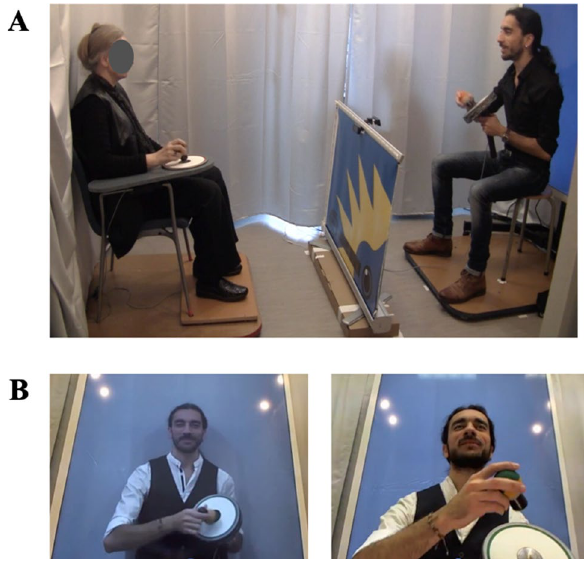
Figure 1. Experimental set-up. ( A ) The participant was seated in front of a musician, who sang and tapped on a tablet in time with the sound sequence’s rhythm. The participant’s chair was placed on force platforms, in order to record his/her overall body motion. ( B ) Manipulation of the social context. The musician’s performance could be displayed on a life-sized screen (the video condition) or truly live (the live